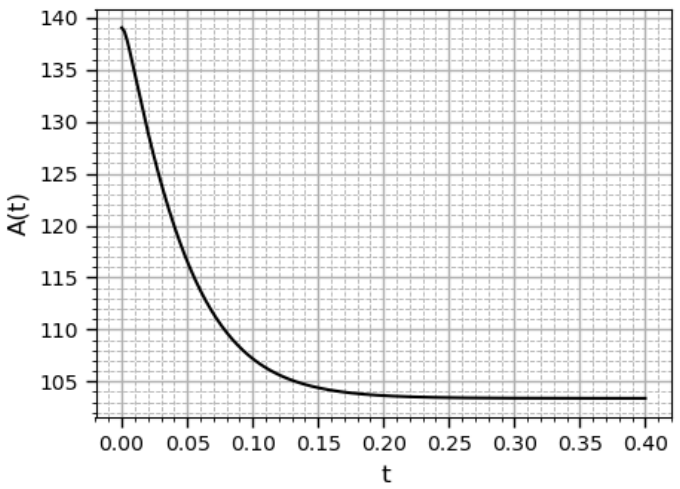
Figure 7. Dependence of the system throughput on time.